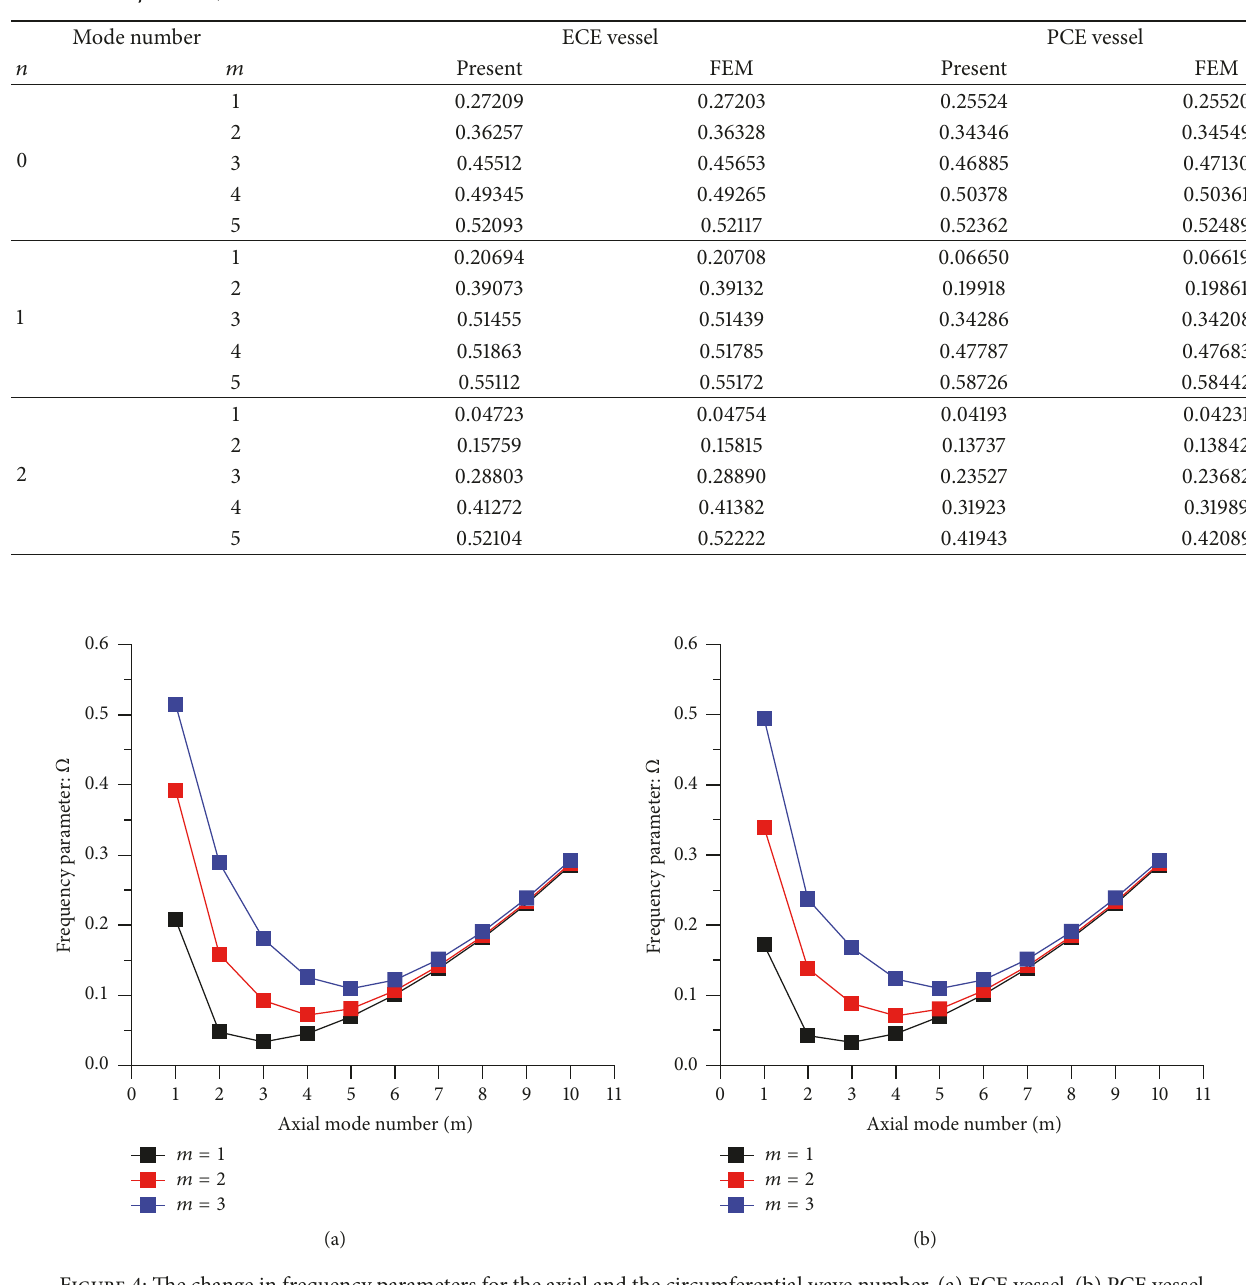
And the structural damping is realized by using a complex modulus 𝐸 𝑑 = (1 + 𝑖𝜂)𝐸 instead of the original Young’s modulus 𝐸 , where 𝜂 (𝜂 = 0.002) is defined as the